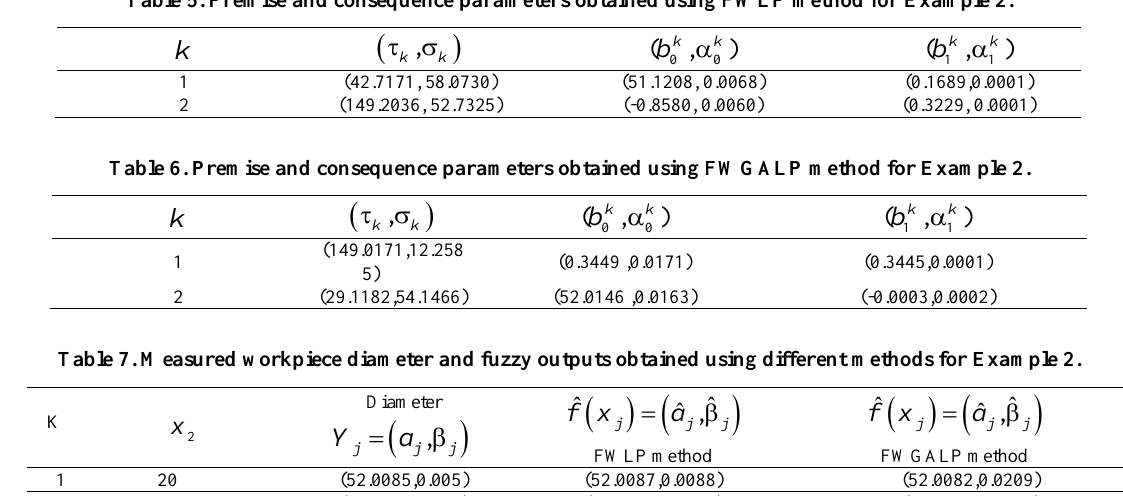
Table 5. Premise and consequence parameters obtained using FWLP method for Example 2.